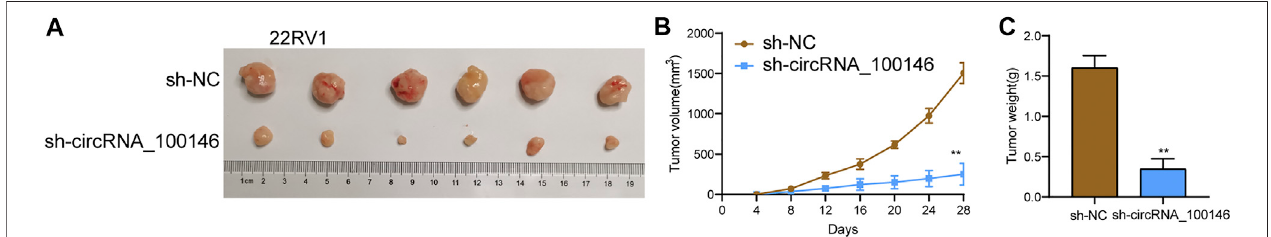
FIGURE 5 | Oncogenic functions of circRNA_100146 knockdown on tumor growth. (A) Tumors from sh-NC or sh-circRNA_100146 group were shown. (B,C) Volume and weight of tumors obtained from sh-NC or sh-circRNA_100146 group were displayed. ** p <